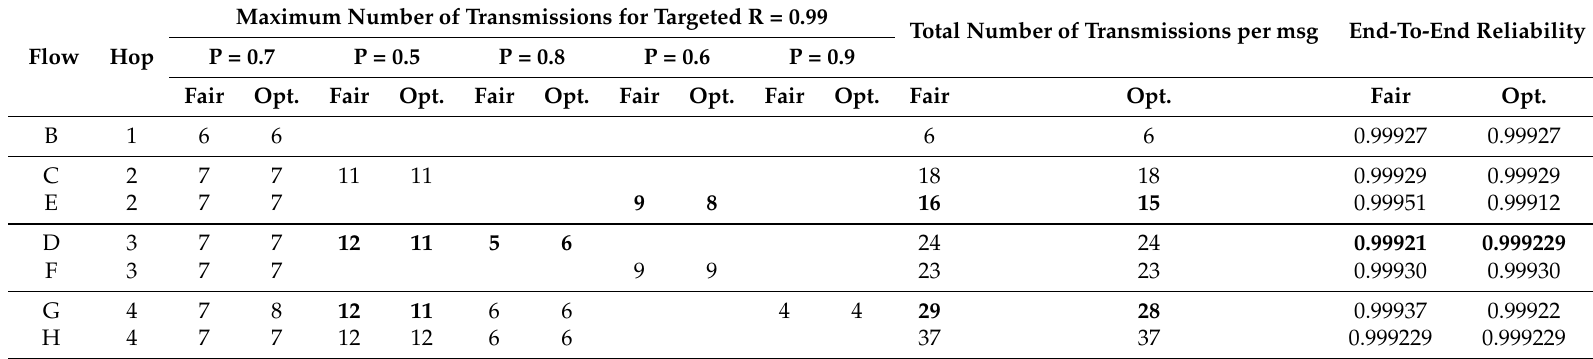
Table 5. Comparison of MFair and MOpt for a targeted end-to-end reliability R = 0.999 on seven flows. Maximum Number of Transmissions for Targeted R = 0.99